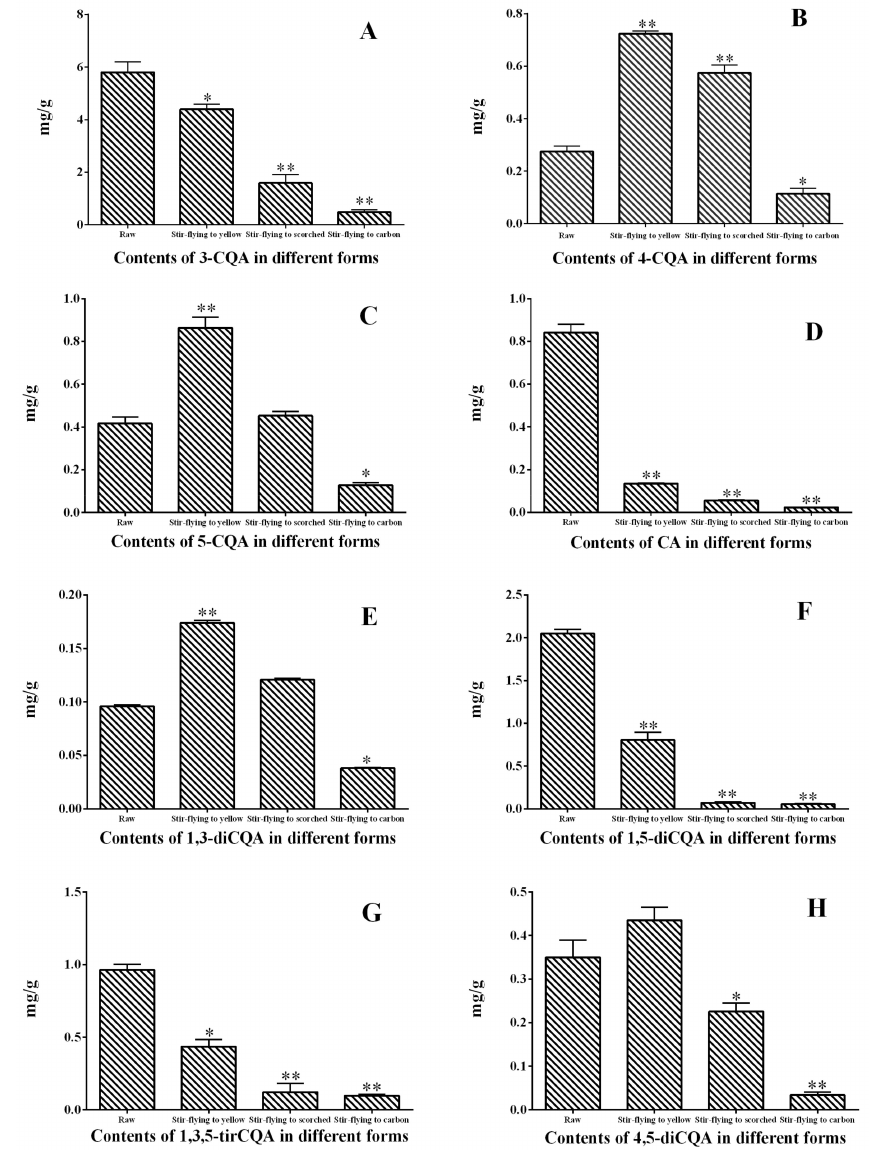
Figure 6. Content (mg/g) of eight components in different forms of XF samples. Data are given as mean ± SD (n = 6). Compared with raw samples, * p < 0.05, ** p <